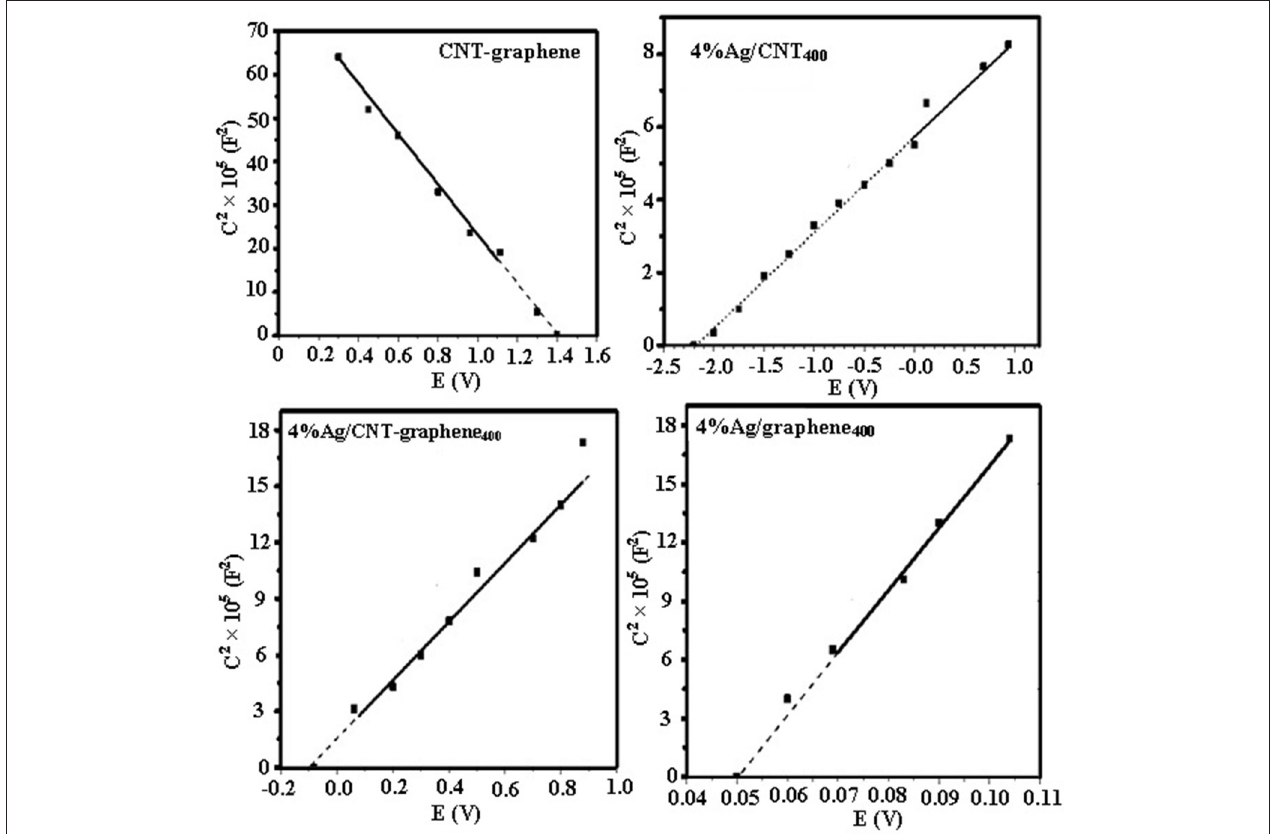
FIGURE 9 | Mott-Schottky plots of 4%Ag/graphene 400 , 4%Ag/CNT 400 , 4%Ag/CNT-graphene 400 , and CNT-graphene catalysts.